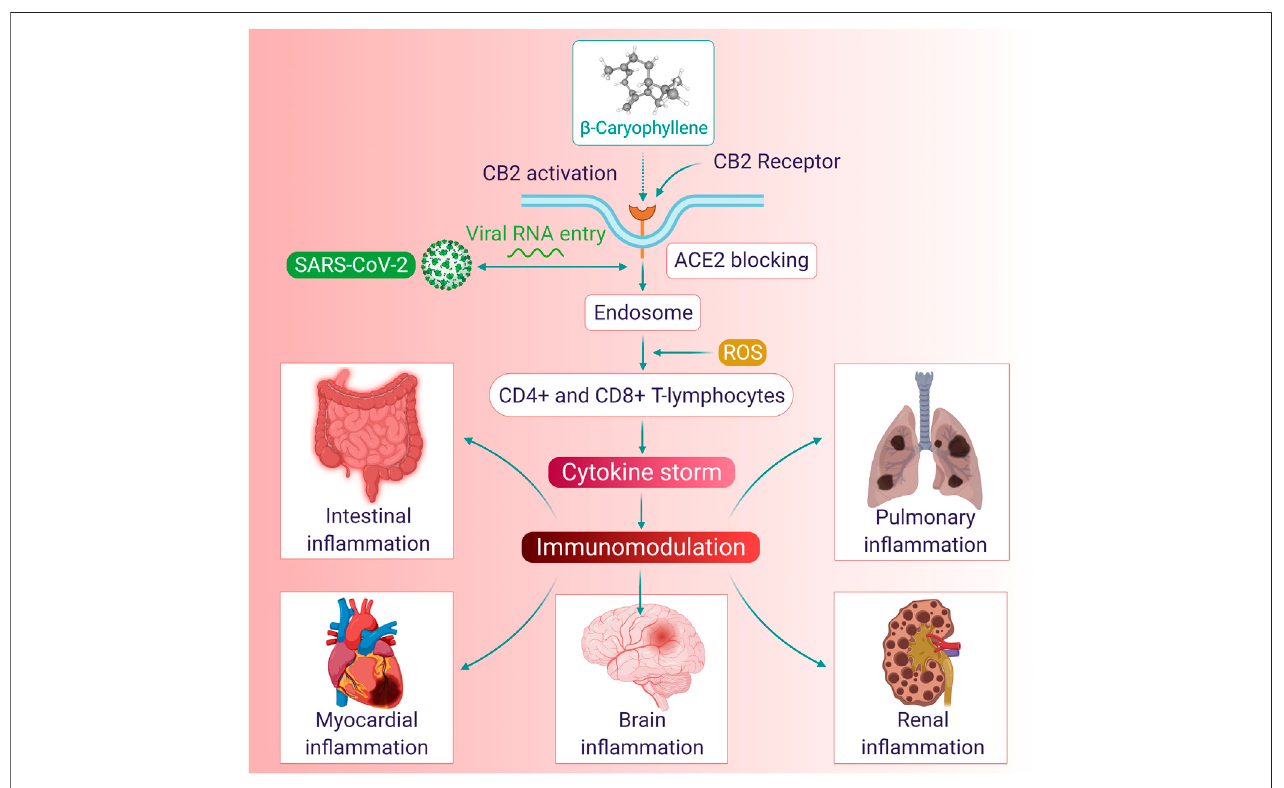
FIGURE 3 | The immunomodulatory mechanisms and organ-protective effects of